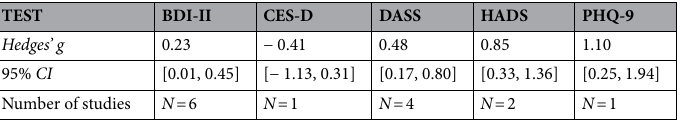
Table 1. Hedges’ g calculated using the questionnaire used to evaluate depressive symptoms as